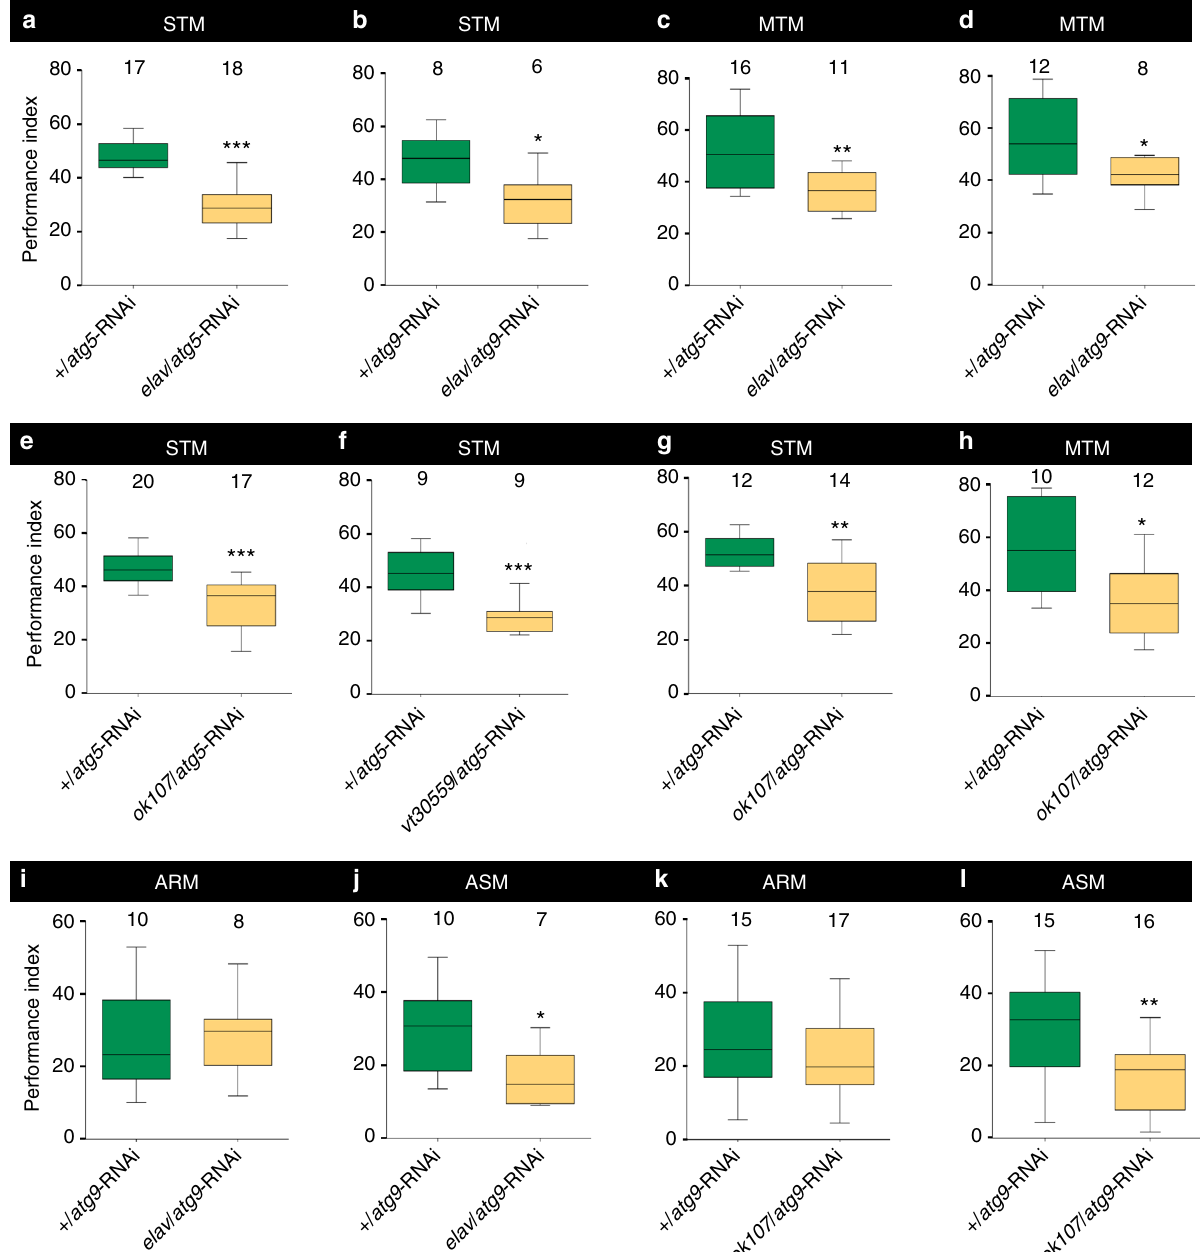
Fig. 2 Neuronal inhibition of autophagy impairs age-sensitive olfactory memory. a Aversive associative memory performance 3 min after training (short- term memory, STM) markedly reduced in elav / atg5 -RNAi compared to + / atg5 -RNAi ( n = 17 – 18; *** p < 0.001; Mann – Whitney U -test). b STM signi fi cantly reduced in elav / atg9 -RNAi compared to + / atg9 -RNAi ( n = 6 – 8; * p < 0.05; Mann – Whitney U -test). c Aversive associative memory performance at 1 h after training (mid-term memory; MTM) of elav / atg5 -RNAi declined signi fi cantly compared to + / atg5 -RNAi ( n = 11 – 16; ** p < 0.01; Mann – Whitney U -test). d MTM signi fi cantly reduced in elav / atg9 -RNAi fl ies compared to + / atg9 -RNAi ( n = 8 – 12; * p < 0.05; Mann – Whitney U -test). e STM signi fi cantly reduced in ok107 / atg5 -RNAi fl ies compared to + / atg5 -RNAi ( n = 17 – 20; *** p < 0.001; Mann – Whitney U -test). f STM signi fi cantly reduced in vt30559 / atg5 -RNAi fl ies compared to + / atg5 -RNAi ( n = 9; *** p < 0.0001; Mann – Whitney U -test). g STM signi fi cantly reduced in ok107 / atg9 -RNAi fl ies compared to + / atg9 - RNAi ( n = 12 – 14; ** p < 0.01; Mann – Whitney U -test). h MTM signi fi cantly reduced in ok107 / atg9 -RNAi fl ies compared to + / atg9 -RNAi ( n = 10 – 12; * p < 0.05; Mann – Whitney U -test). i Aversive associative memory performance at 1 h after training, anesthesia-resistant memory (ARM) and j anesthesia- sensitive memory (ASM) of elav / atg9 -RNAi compared to + / atg9 -RNAi ( n = 7 – 10; * p < 0.05; ns p > 0.5; Mann – Whitney U -test). k ARM and l ASM of ok107 / atg9 -RNAi compared to + / atg9 -RNAi ( n = 15 – 17; ** p < 0.01; ns p > 0.5; Mann – Whitney U -test). In the box and whisker plots, the middle line of a box represents the median (50th percentile) and the terminal lines of a box represent the 25th and 75th percentile. The whiskers represent the lowest and